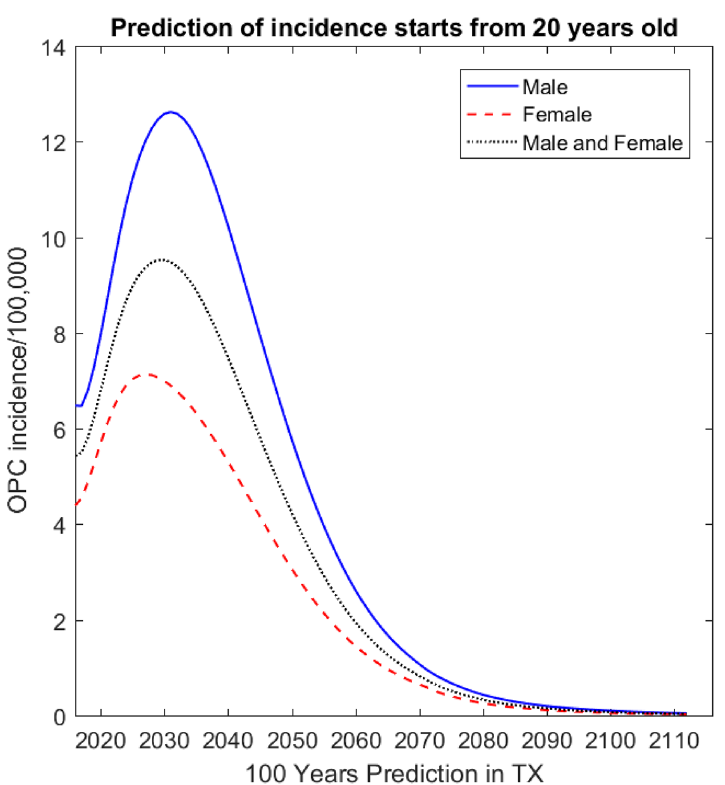
Figure 2. Prediction by the model of oropharyngeal cancer (OPC) incidence for Texas (TX) for 100 years, beginning at age 20